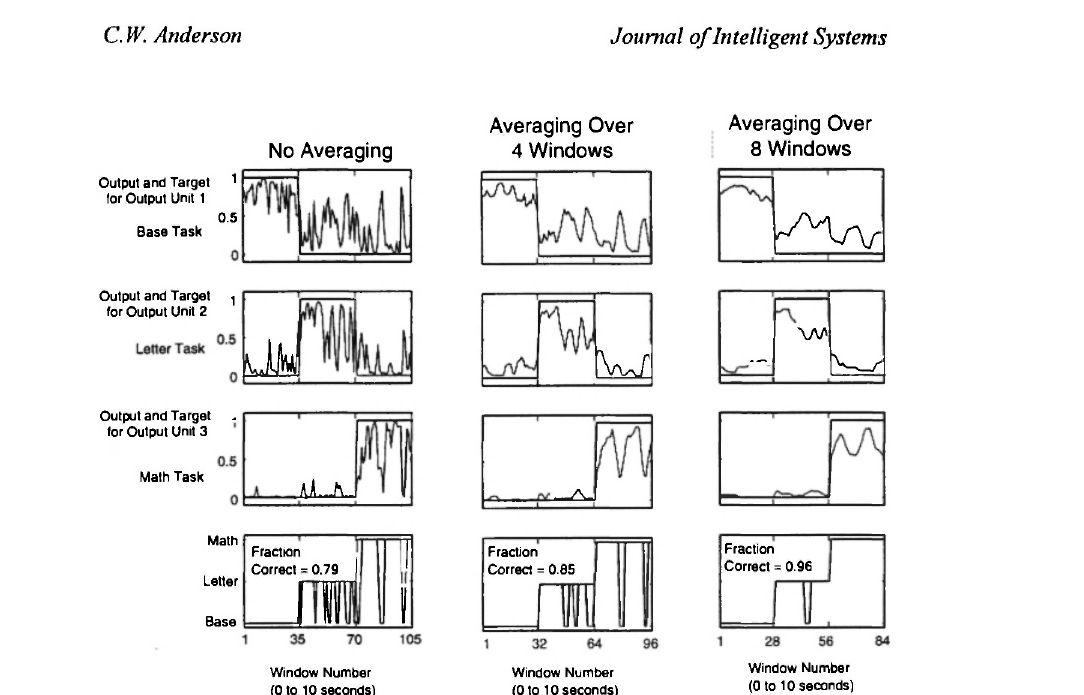
Fig. 9: Network output values and desired values for one test trial. The first three rows of graphs show the values of the three network outputs over the 105 test windows. Windows from the three tasks are concentrated in each graph, hiding the rest period between the recording of data from each task. Also, the order of the tasks does not reflect the order in which the tasks were performed. The fourth row of graphs plots the true task and the task predicted by network, determined by the output unit having the largest output. The first column of graphs is without averaging over consecutive windows, the second is for averaging the network output over four consecutive windows, while the third column is for averaging over eight